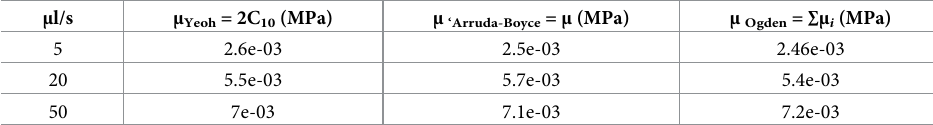
Table 2. Initial shear moduli estimated by the SEFs at the three deformation